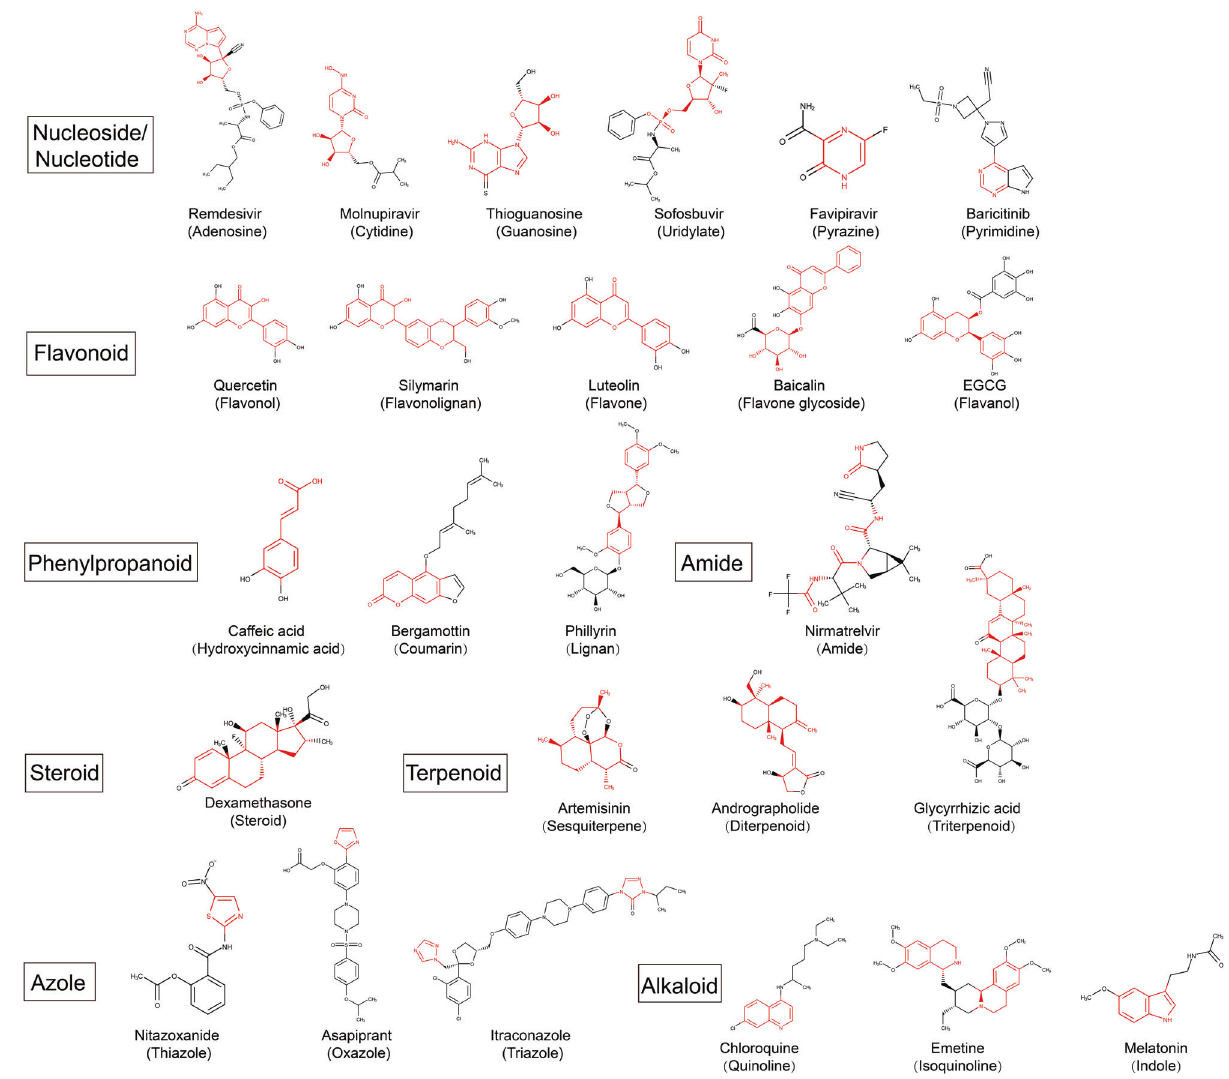
Fig. 8 Chemical structure of representative small molecules and their backbone (labeled in